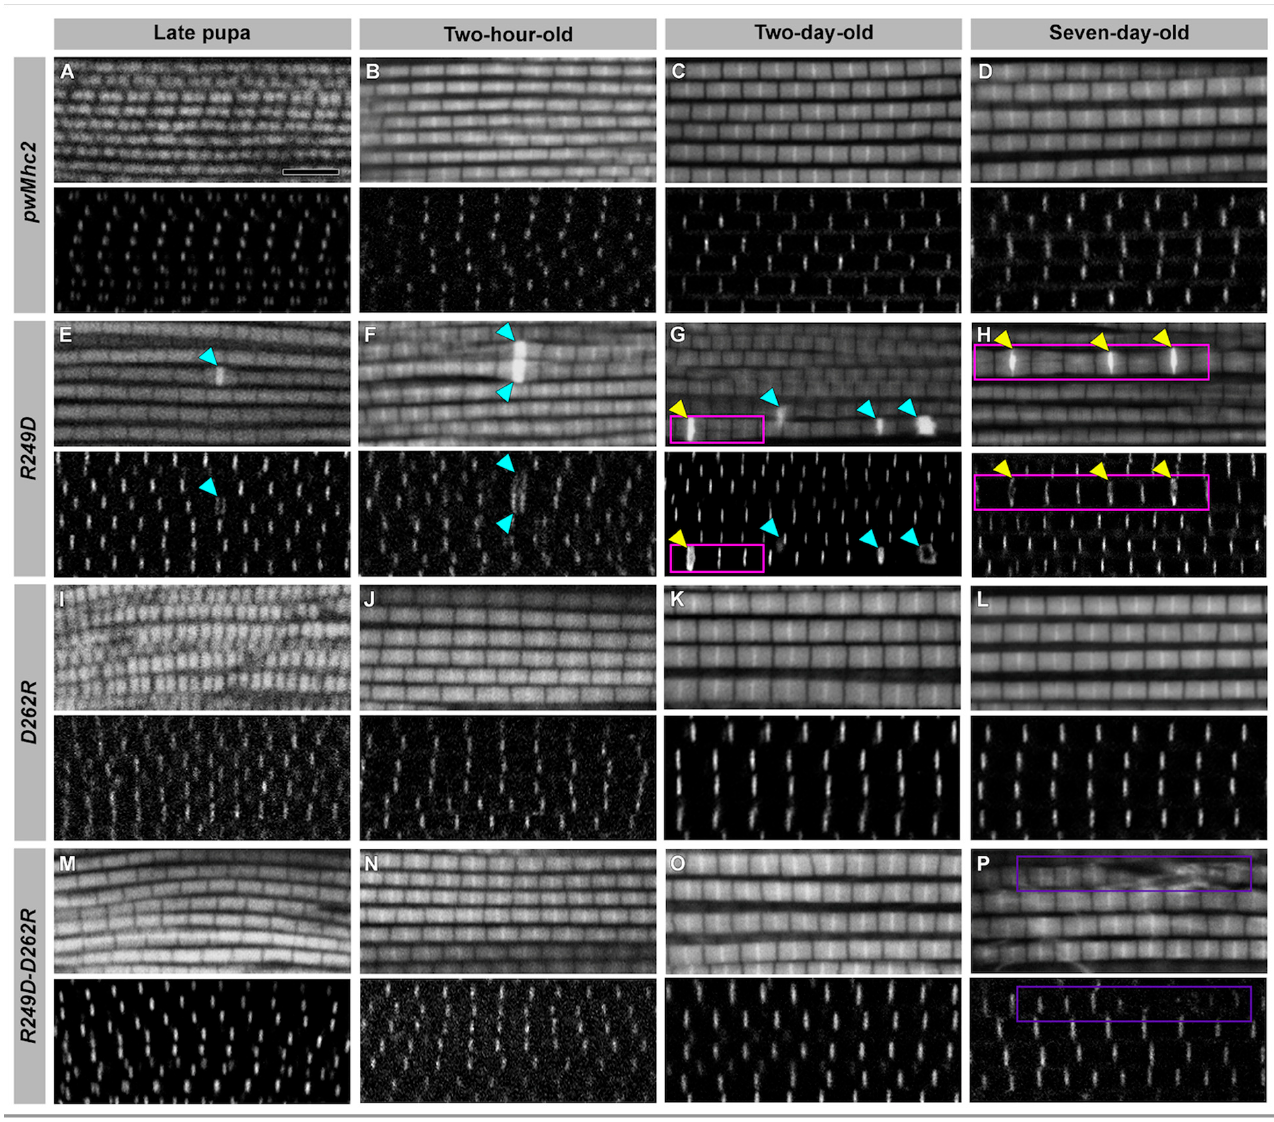
Figure 3. Confocal images of R249D , D262R and R249D-D262R myofibrils show defects in R249D that are rescued in the double mutant. Myofibrils from four developmental stages were imaged in longitudinal orientation to assess sarcomere structure. Muscles are stained for actin with fluorescent phalloidin and with an antibody to alpha-actinin, which localizes at Z-lines. pwMhc2 controls display regular Z- and M-lines within sarcomeric structures throughout development: ( A ) pwMhc2 late-stage pupa, ( B ) pwMhc2 two-hour-old adult, ( C ) pwMhc2 two-day-old adult, ( D ) pwMhc2 seven- day-old adult. ( E – H ) Myofibrils from pwMhcR249D display minor assembly defects that are exacer- bated during development. These include thick Z-line-like structures (cyan arrowheads), myofibril branching (magenta boxes), and occasionally both defects (yellow arrowheads). ( I – L ) Myofibrils from pwMhcD262R show essentially wild-type sarcomere structures throughout development. ( M ) Myofibrils assemble normally in the pwMhcR249D - D262R double mutant at the late-pupal stage. ( N – O ) Normal structure is maintained in young adults for pwMhcR249D - D262R . However, defects are present in seven-day-old pwMhcR249D - D262R myofibrils (( P ), purple box). Thus, at this level of resolution, the D262R mutation rescues the various ultrastructural defects seen in pwMhcR249D myofibril assembly and early adult life . Scale bar, 5 µm.